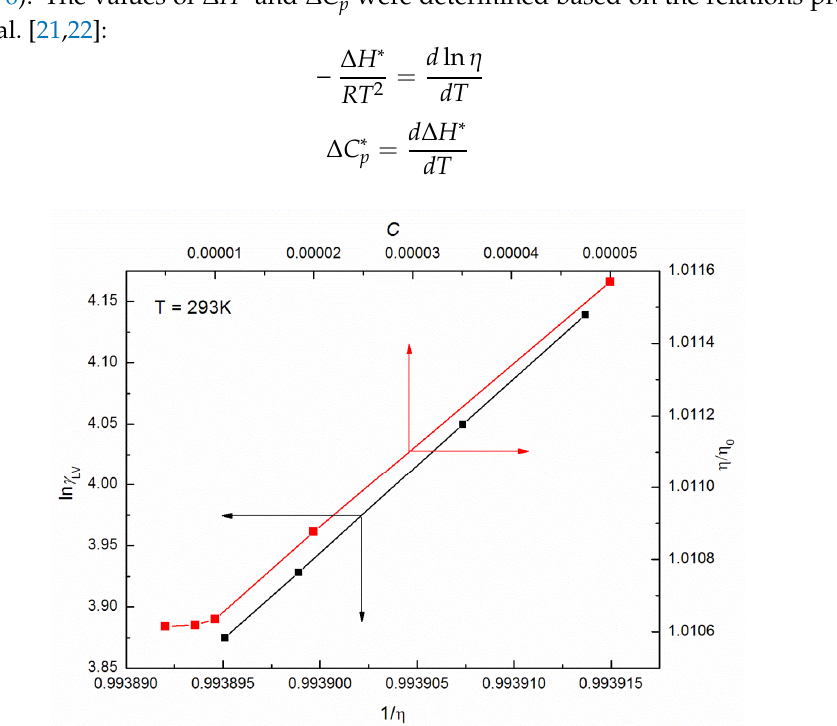
 vs.  /1 as well as /   vs. C for the aqueous solutions LV 0